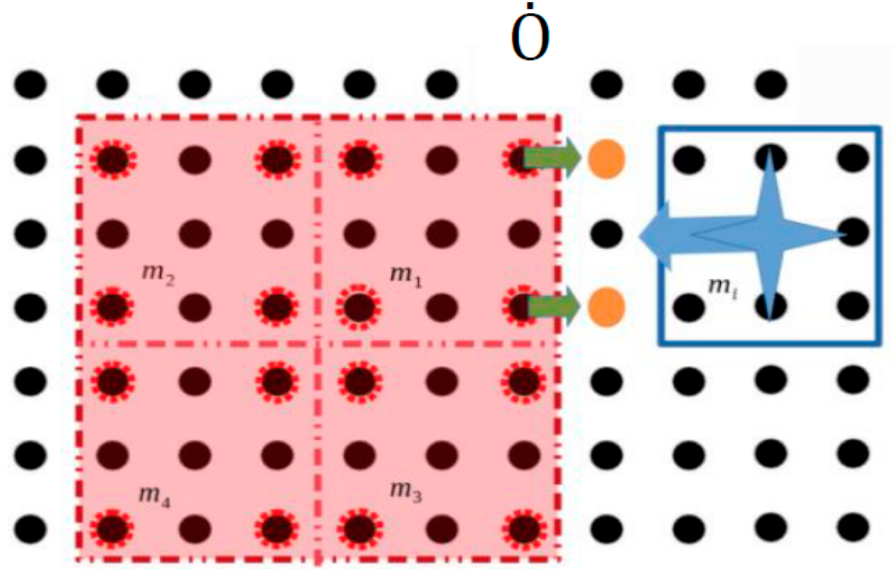
Figure 13. Influence of the activation to the group of assembled microparts.